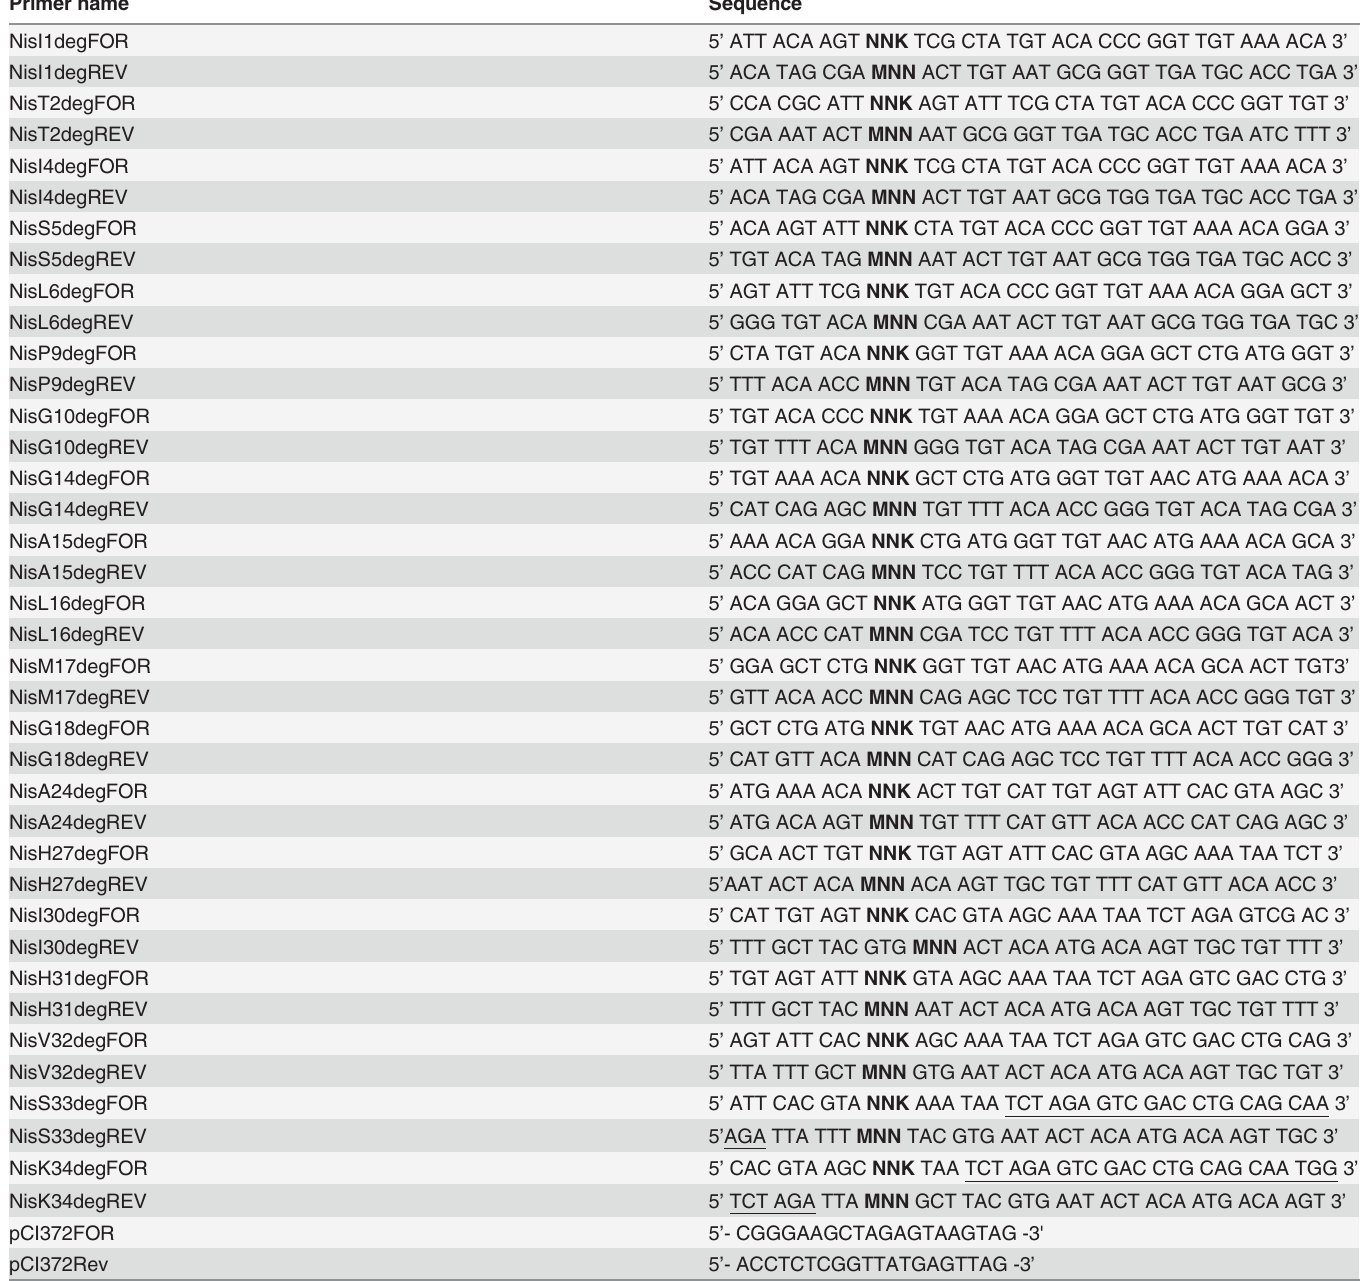
Table 1. Oligonucleotides utilised in this study. Primer name